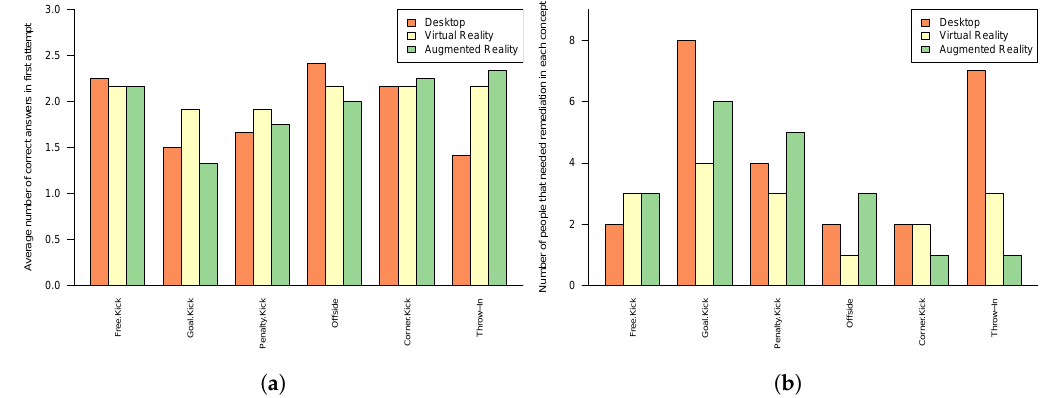
Figure 9. ( a ) This figure depicts the average number of correct answers participants achieved in their first attempt; ( b ) Shows the number of people that needed remediation loops for each concept and interface (see Table